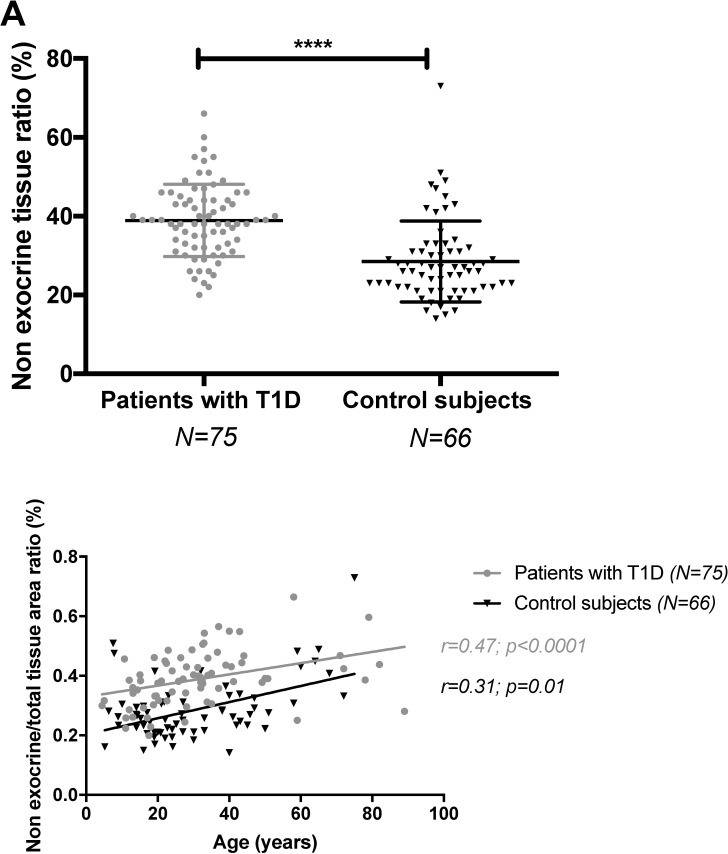
Non-exocrine-non-endocrine tissue area/total tissue area ratio in patients with T1D and control subjects (A) and its correlation with age (B). Data representation is the same as in Figs 5 and 6, respectively.